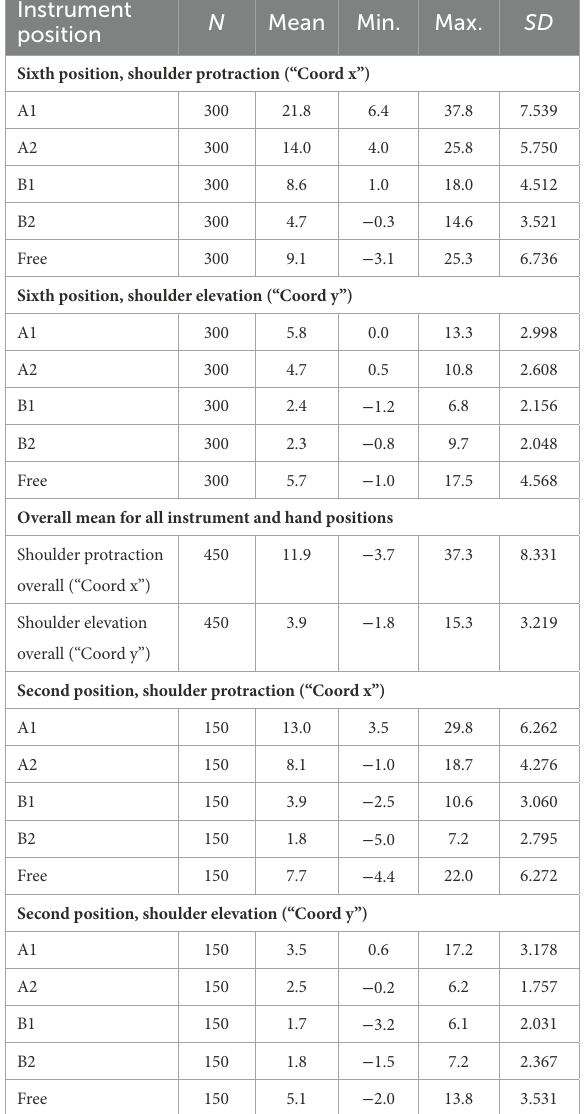
by hand and instrument position and compared with the overall mean of values for protraction (“Coord x”) and elevation (“Coord y”). Instrument